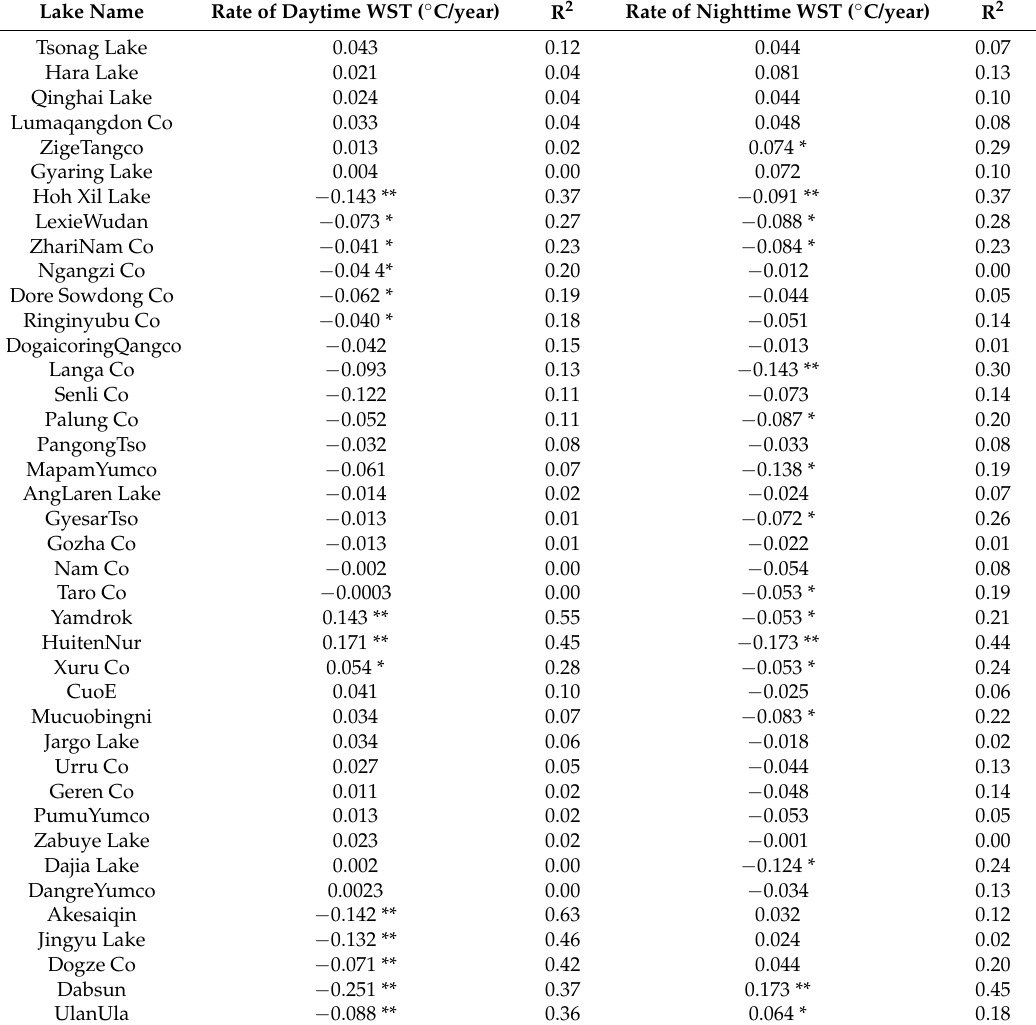
Table 2. Lake water surface temperature change rates derived from MODIS LST regressing against year between 2001 and 2015 for both daytime and nighttime series data, these rates of temperature change in grey color are showing a cooling trend, while the rest showing warming